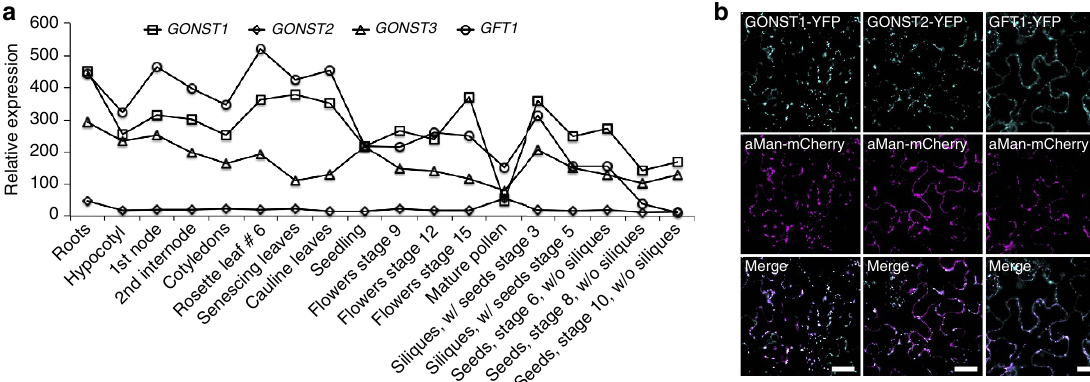
Figure 2 | Expression pattern and sub-cellular localizations of Arabidopsis GONSTmembers. ( a ) Expression patterns of GFT1 and GONST1-3 in different Arabidopsis organs and developmental stages using the AtGenExpress developmental data set 28 . ( b ) Sub-cellular localizations of GFT1, GONST1 and GONST2. C-terminal YFP fusion constructs were transiently co-expressed with the aMan-mCherry Golgi marker in N. benthamiana leaves. Scale bar, 25 m m. NATURE COMMUNICATIONS|7:12119|DOI: